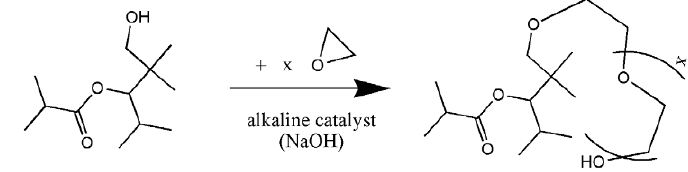
Figure 2. General diagram of ethoxylation of 2,2,4-trimethyl-1,3-pentanediol